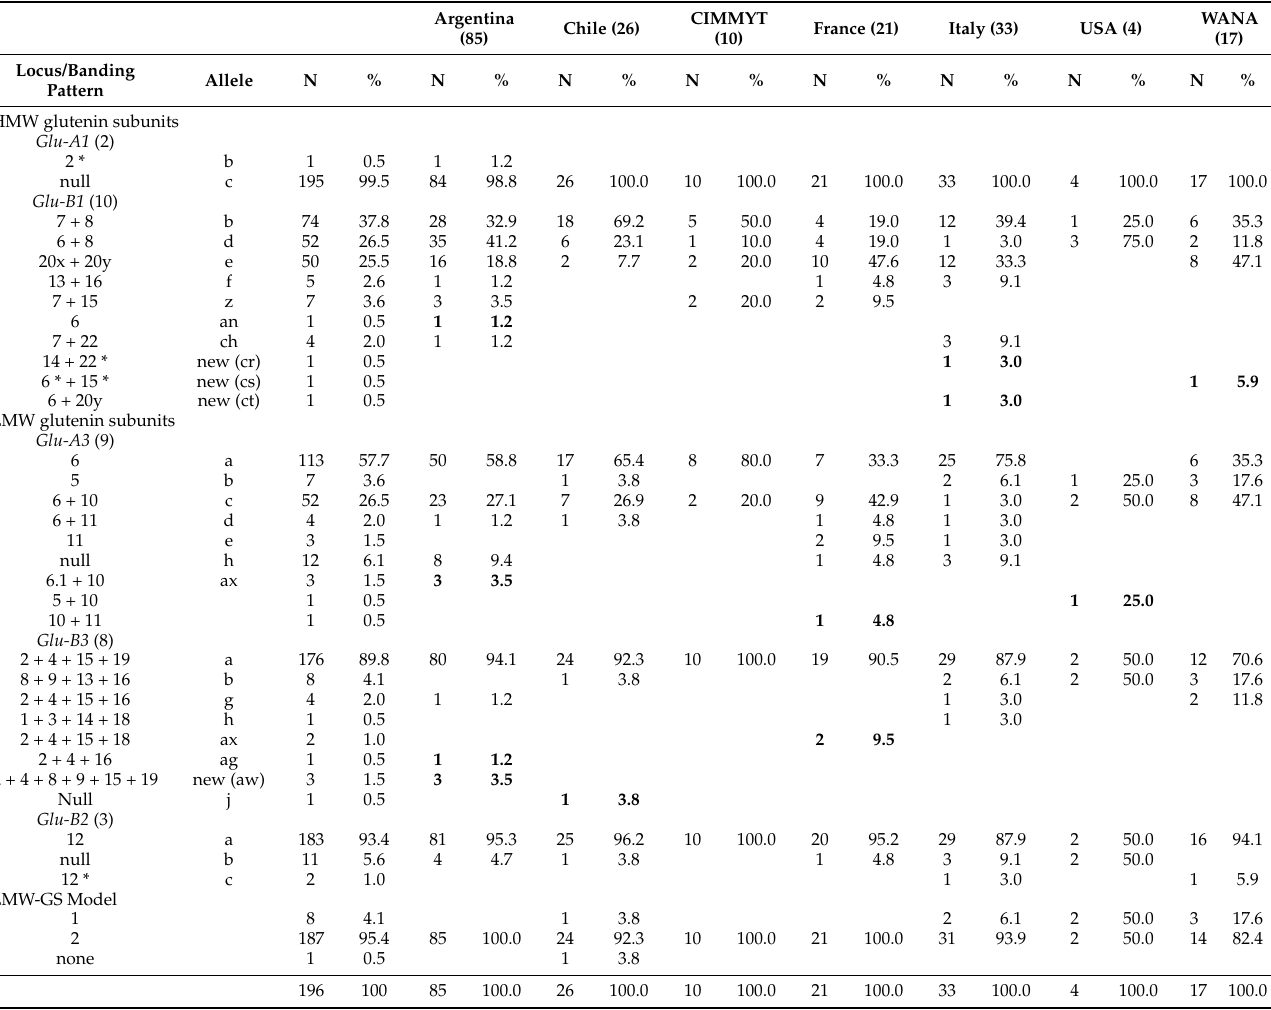
Table 1. Allele frequency at five glutenin loci (HMW-GS and LMW-GS) detected in a worldwide collection of 196 du- rum